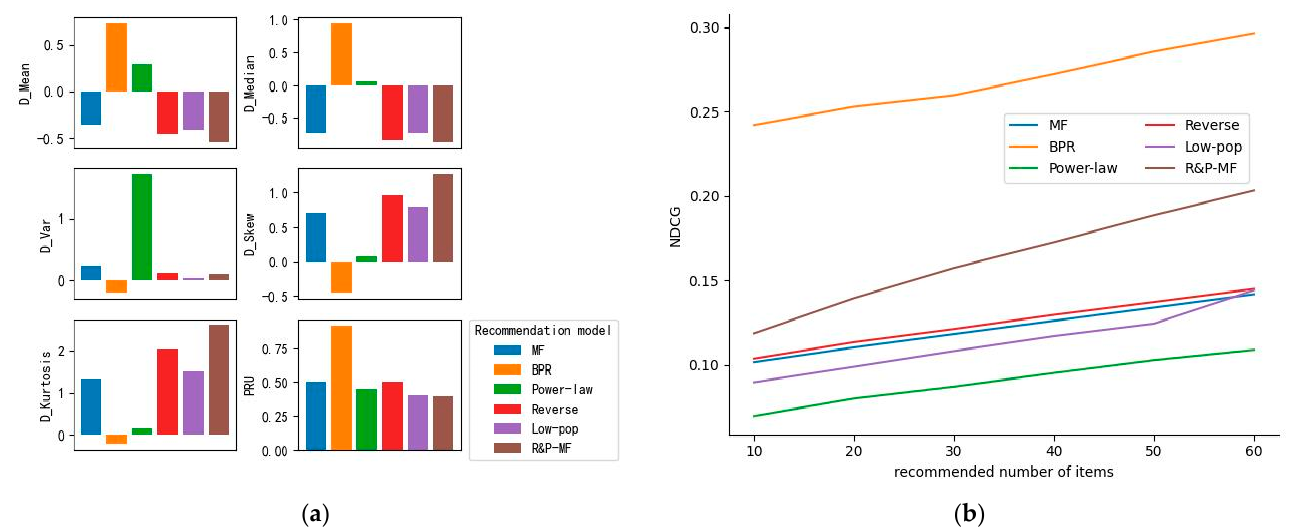
Figure 1. Experimental Settings: λ = 0.02, λ 1 = 0.04, λ 2 = 0.04, λ 3 = 0.002, λ 4 = 0.03. ( a ) Results of all models (MF, BPR, Power ‐ law, Reverse, Low ‐ pop, and R&P ‐ MF) with D_M @ 60 and PRU as metrics;